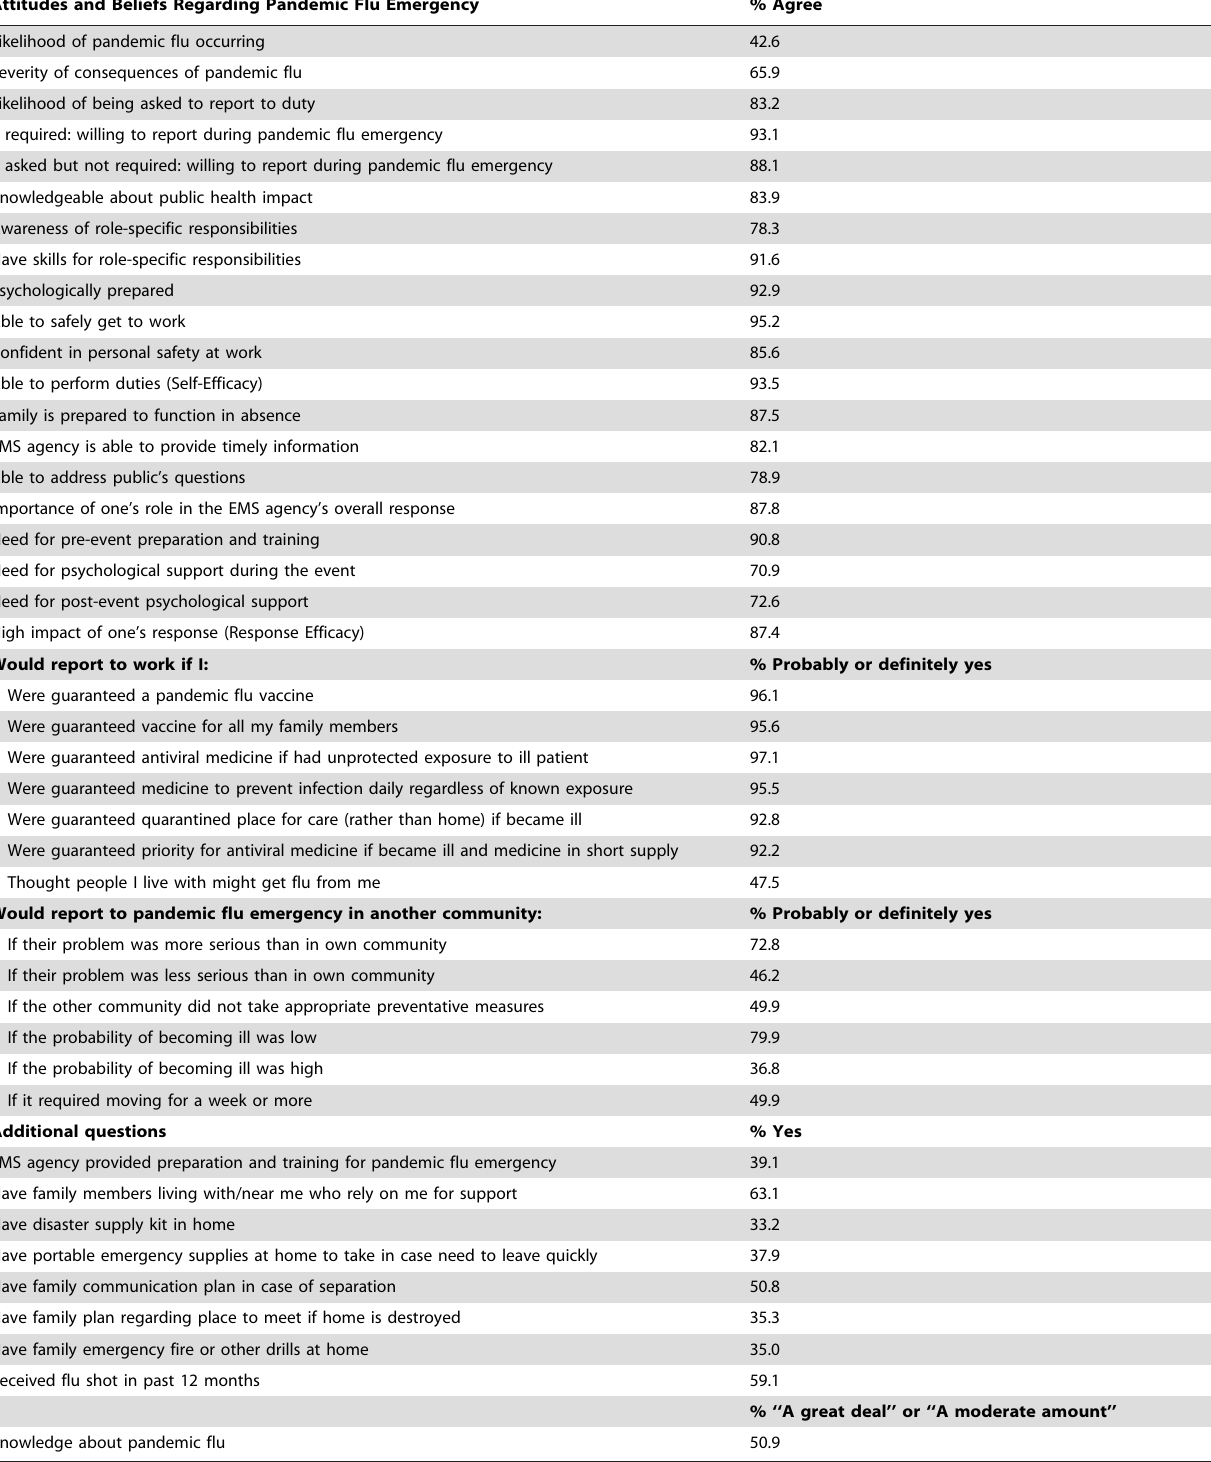
Table 2. Survey responses of EMS clinical service providers